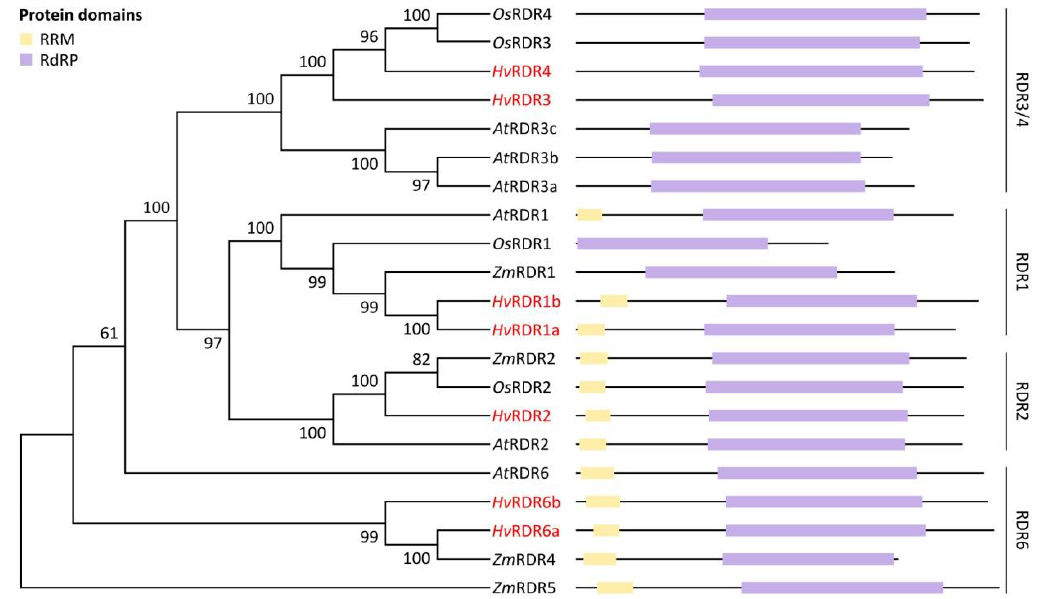
Figure 3. Phylogenetic relationship and conserved domains of A. thaliana , O. sativa , Z mays and H. vulgare AGO proteins. Phylogenetic trees were constructed as described in Figure 1 legend. The bootstrap values are shown next to the branches. Conserved domains were identified with the SMART server [84]. The barley AGOs identified in this study are marked with red.